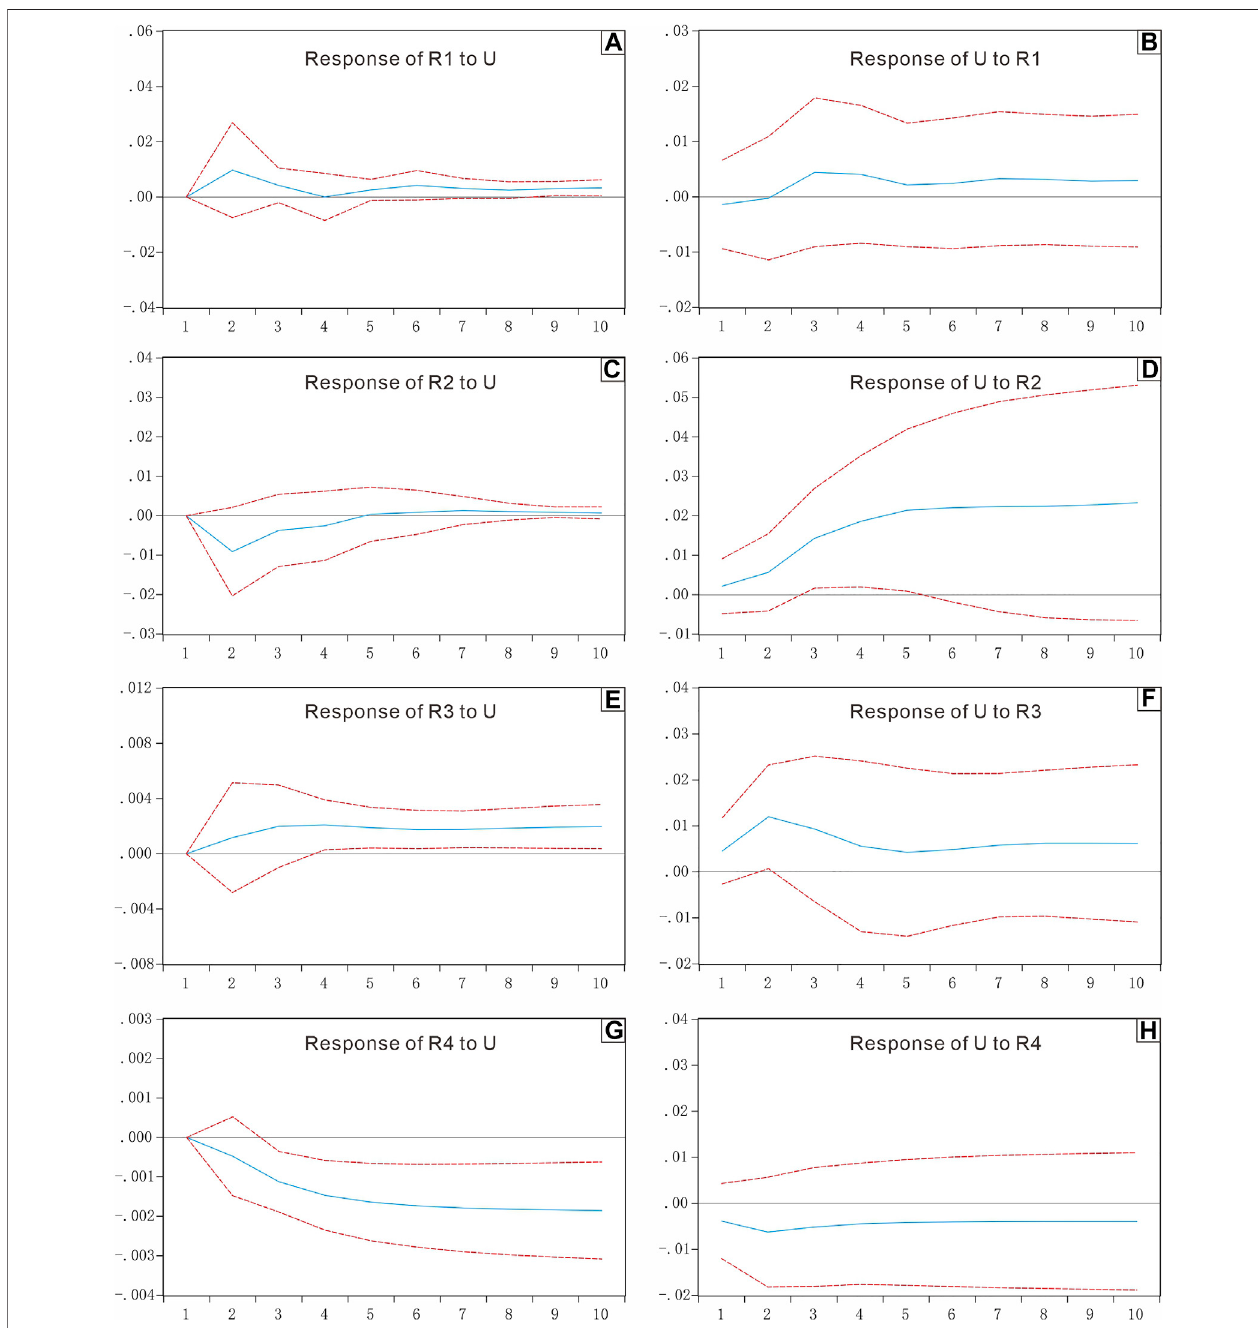
FIGURE 4 | Diagrams show impulse response of water resources and new urbanization for R1 to U (A) , U to R1 (B) , R2 to U (C) , U to R2 (D) , R3 to U (E) , U to R3 (F) , R4 to U (G) and U to R4 (H) .